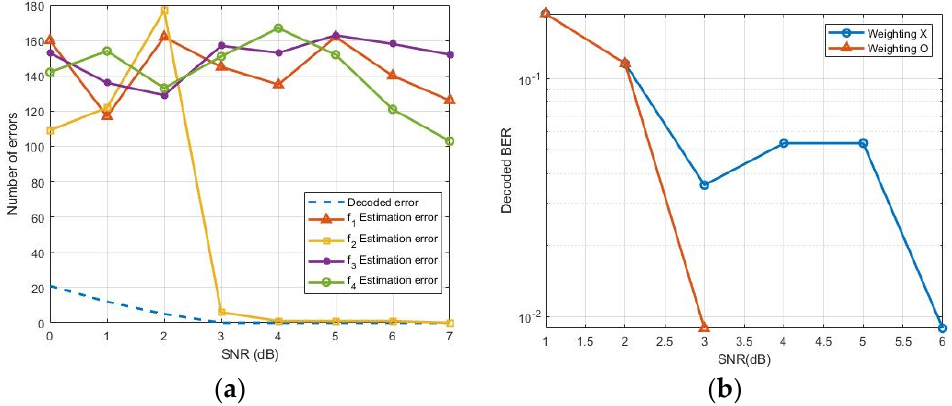
Figure 5. BER performance of weighted multi-band: ( a ) number of errors for multi-band and ( b ) performance comparison between weighting and non-weighting.